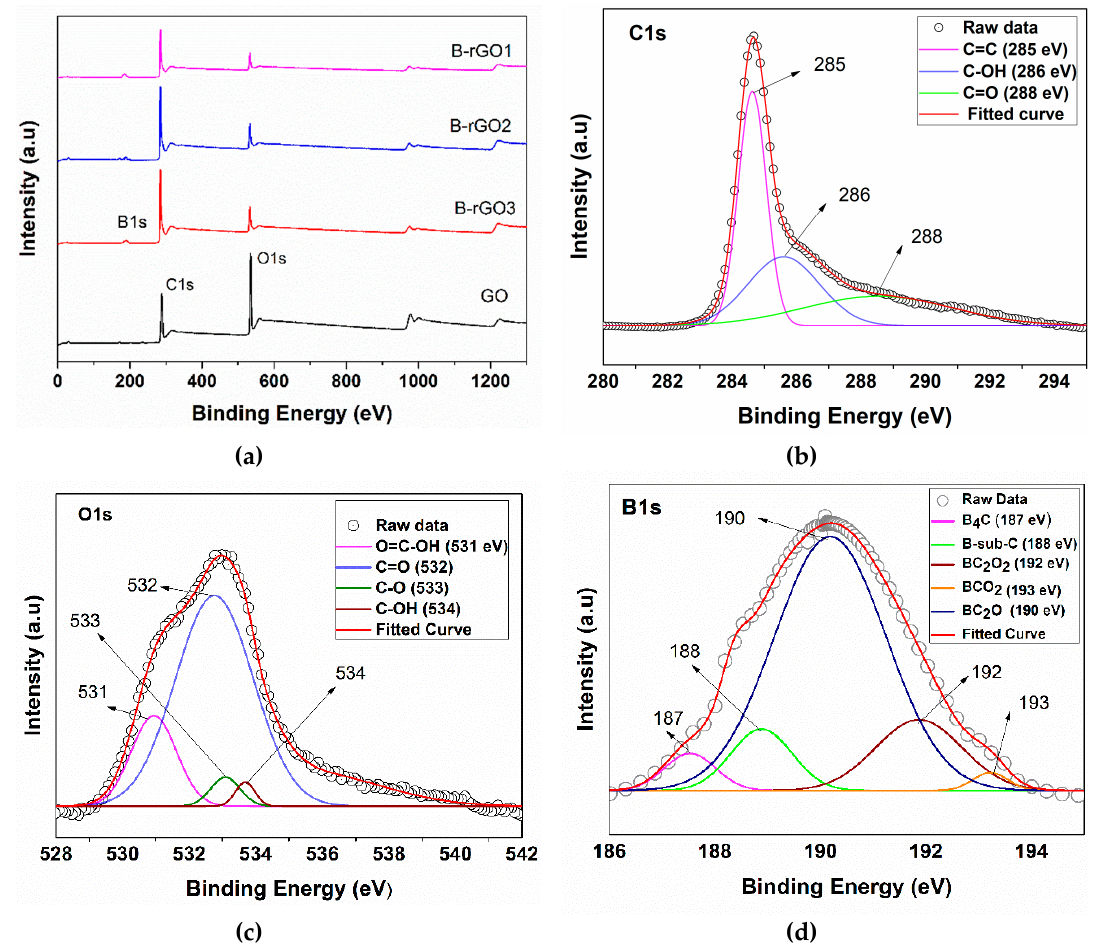
Figure 3. ( a ) XPS survey analysis of GO and B-rGO samples (B-rGO1, B-rGO2, and B-rGO3, respectively). From ( b ) to ( c ) depicts the XPS deconvoluted peaks of C1s ( b ), O1s ( c ), and B1s ( d ) observed from XPS analysis of B-rGO. Table 1. The at.% of each element in each B-rGO samples determined in the XPS analysis. Material C (at.%) O (at.%) B